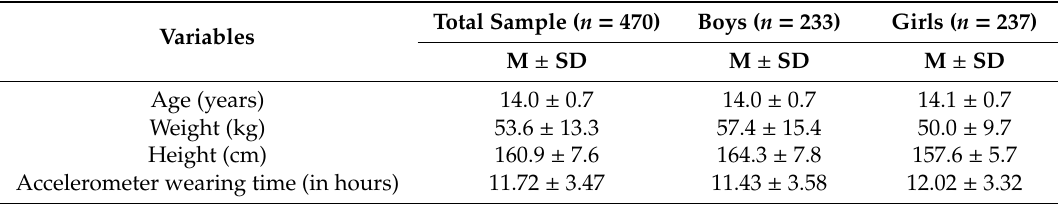
Table 1. Demographic characteristics of study